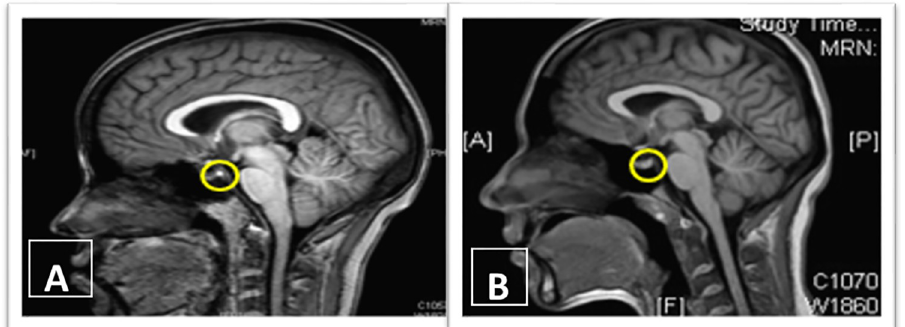
Fig 1. Posterior Pituitary Bright Spot (PPBS). (A) Presence of PPBS and(B) Absence of PPBS.